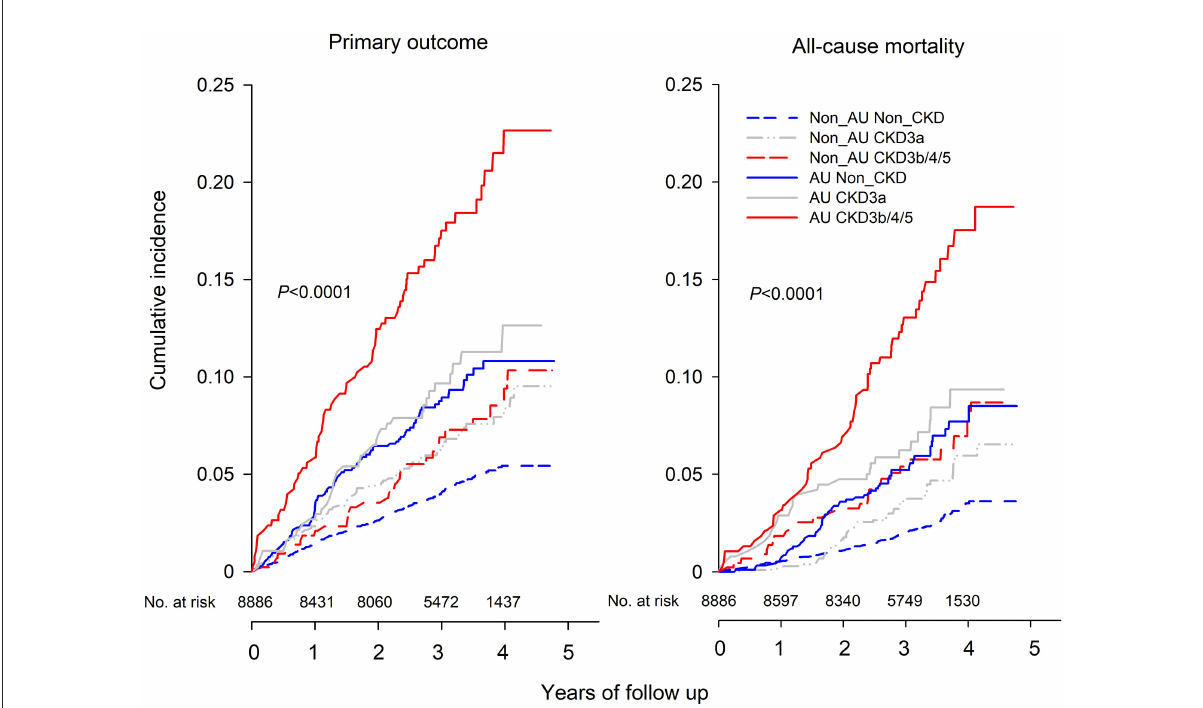
FIGURE2 Kaplan-Meier curve of cumulative incidence for primary outcome (left) and all-cause mortality (right) according to the GFR and Albuminuria categories at baseline. The six subgroups included Non_AU Non_CKD (UACR < 30 mg/g and eGFR ≥ 60 mL/min/1.73 m 2 ), Non_AU CKD3a (UACR < 30 mg/g and eGFR of 45–59 mL/min/1.73 m 2 ), Non_AU CKD3b/4/5 (UACR < 30 mg/g and eGFR of < 45 mL/min/1.73 m 2 ), AU Non_CKD (UACR ≥ 30 mg/g and eGFR ≥ 60 mL/min/1.73 m 2 ), AU CKD 3a (UACR ≥ 30 mg/g and eGFR of 45–59 mL/min/1.73 m 2 ), and AU CKD 3b/4/5 (UACR ≥ 30 mg/g and eGFR of < 45 mL/min/1.73 m 2